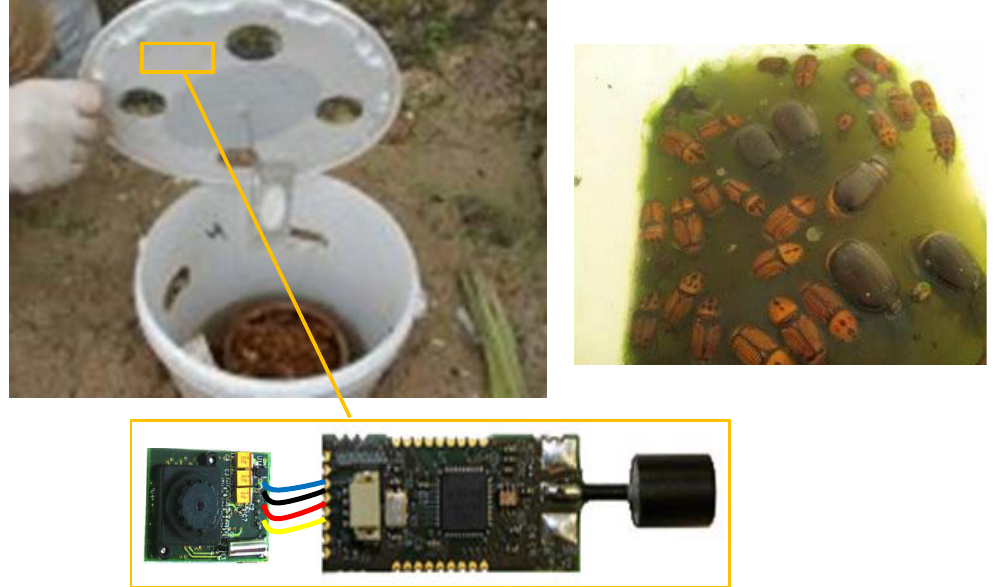
Figure 2. An example of one RPW trap, a snapshot of trap contents, and our wireless image sensor